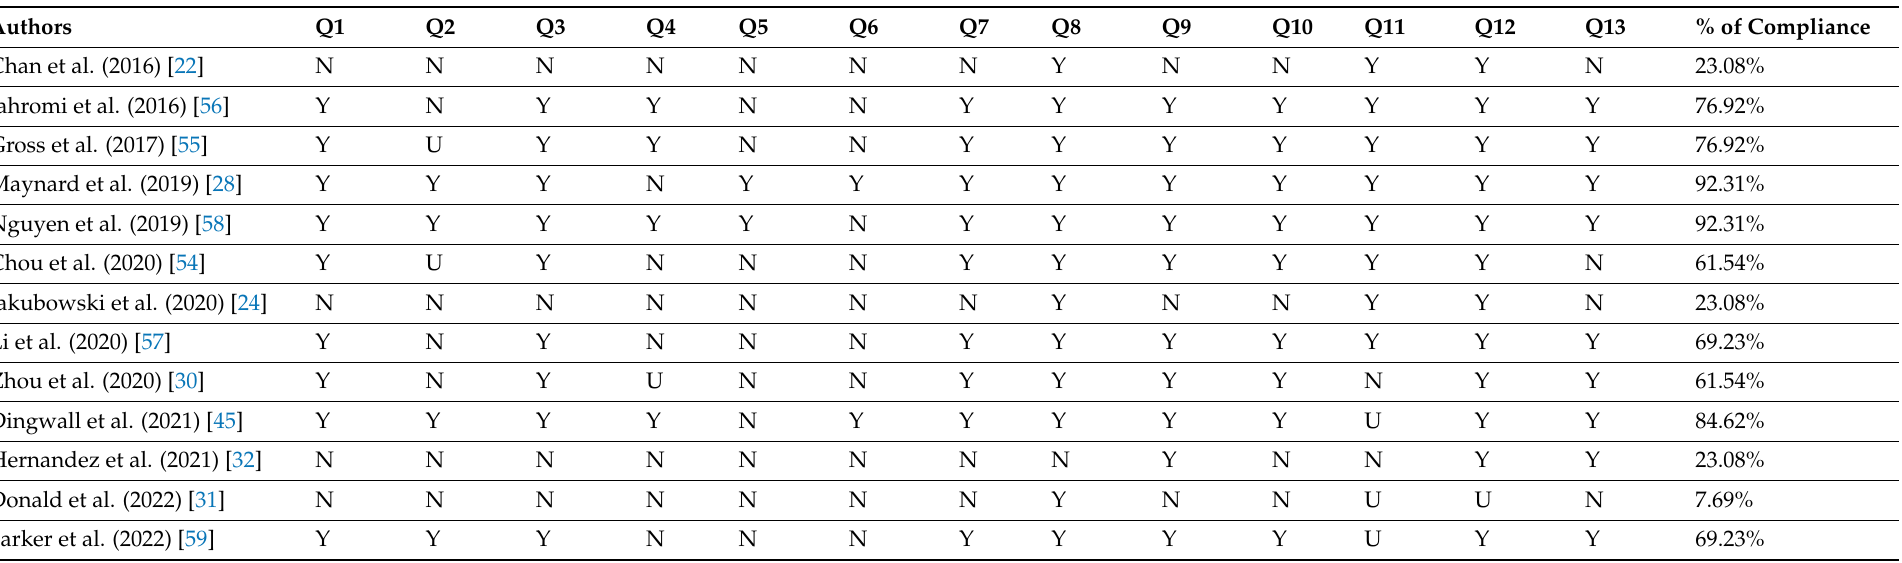
Table 1. Risk of bias of